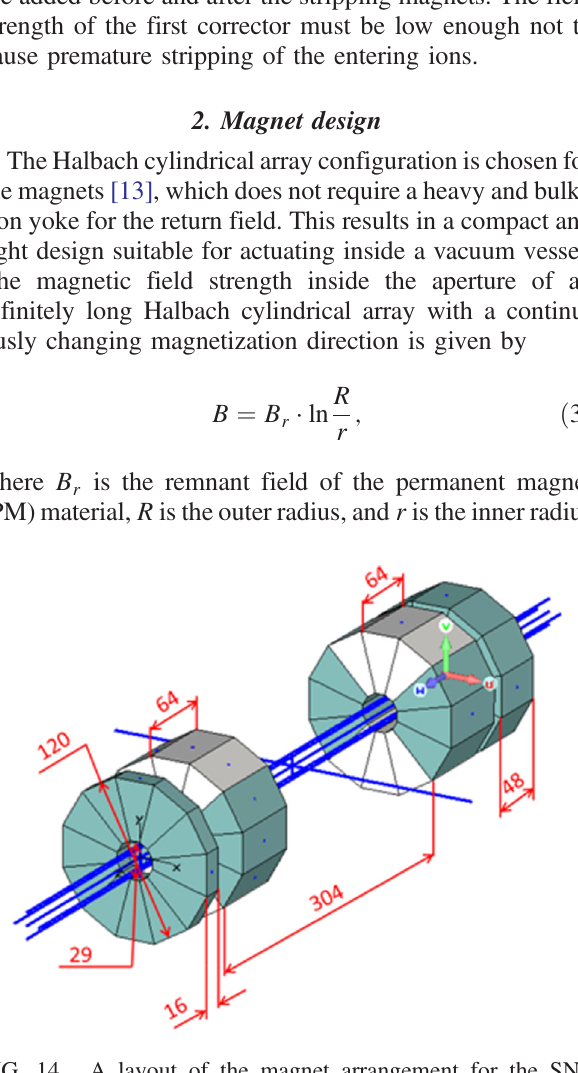
FIG. 14. A layout of the magnet arrangement for the SNS stripping experiment. Dimensions are in